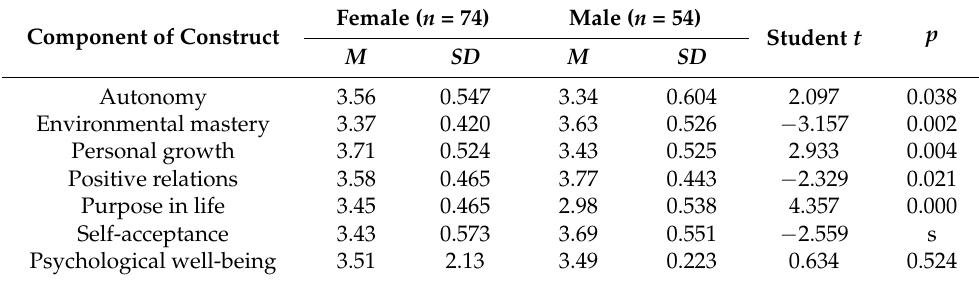
Table 1. The scores of psychological well-being construct components in terms of gender *. Component of Construct